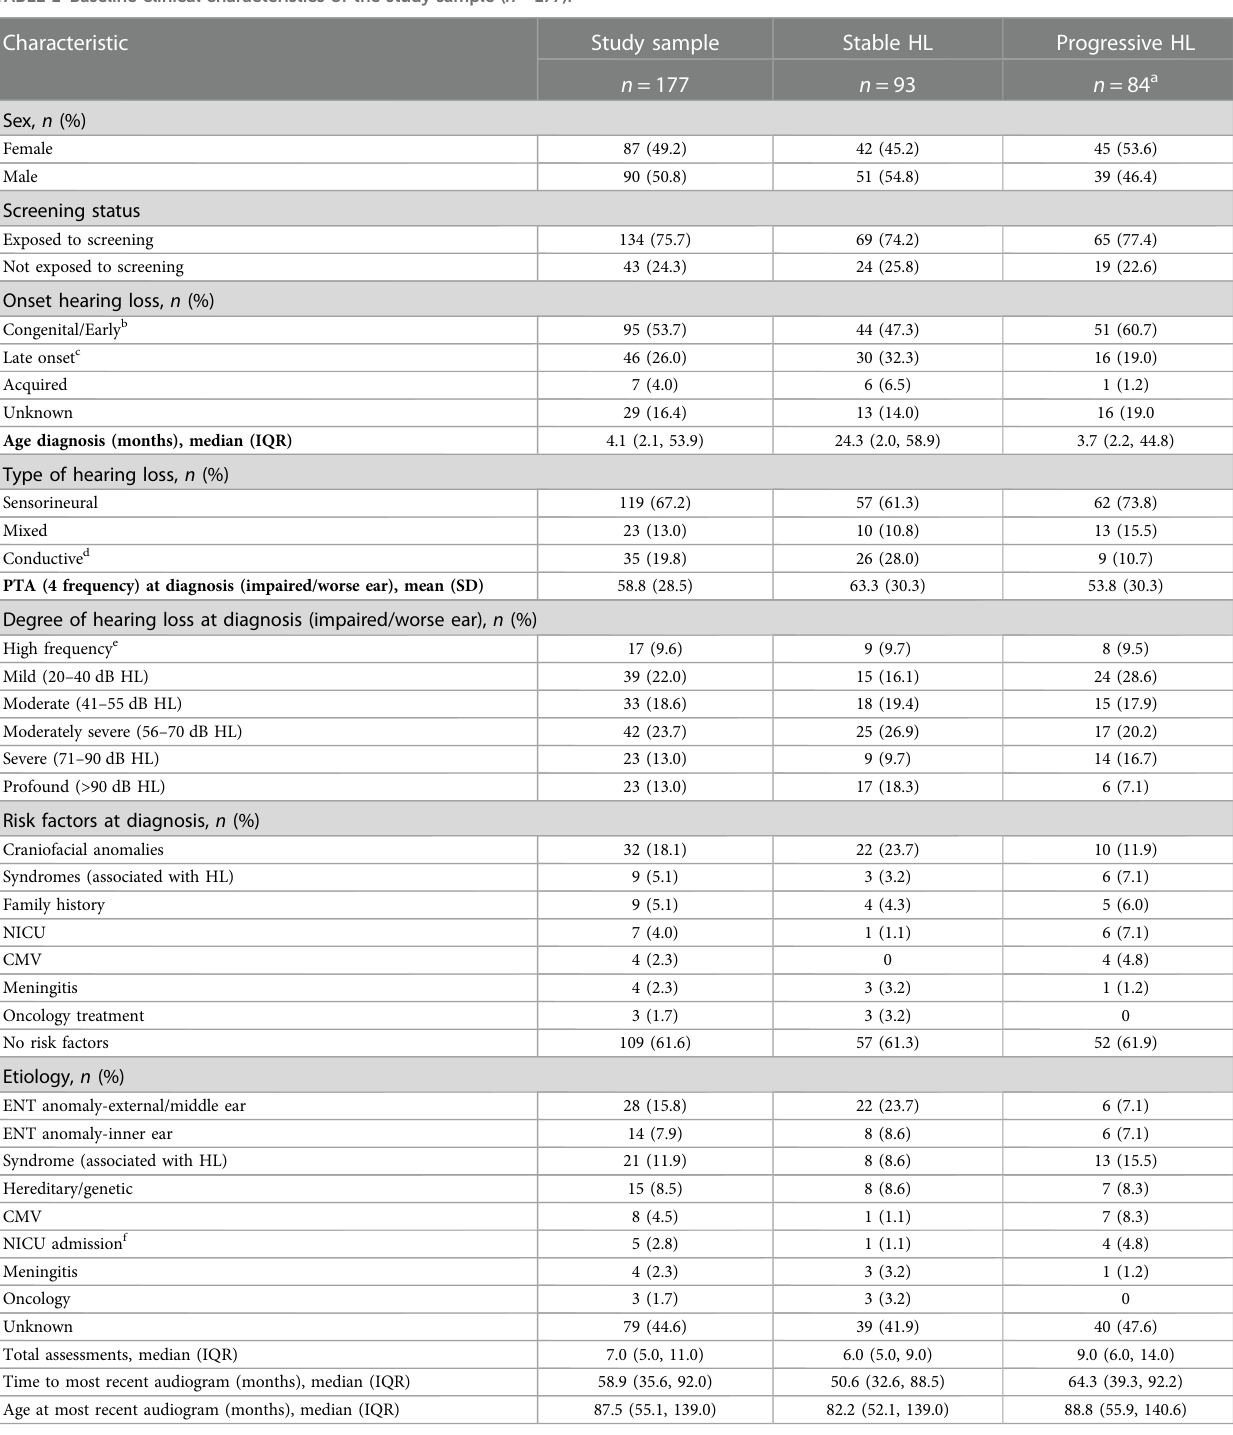
TABLE 1 Baseline clinical characteristics of the study sample ( n